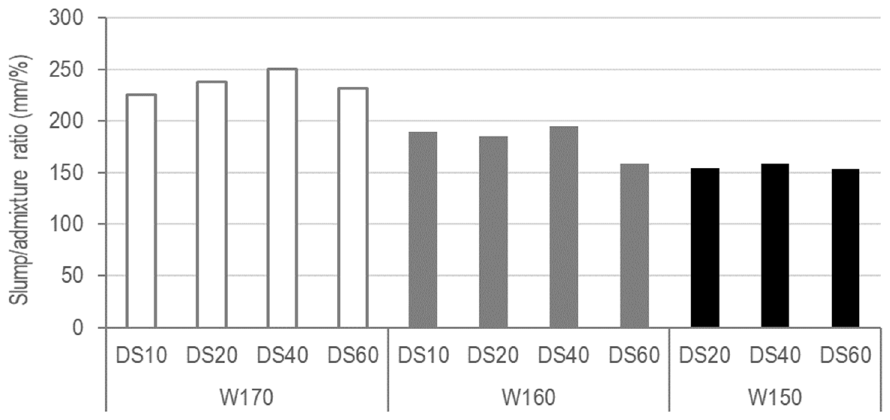
Figure 4. Slump/AD ratios calculated for the different concrete mixtures used in this study.